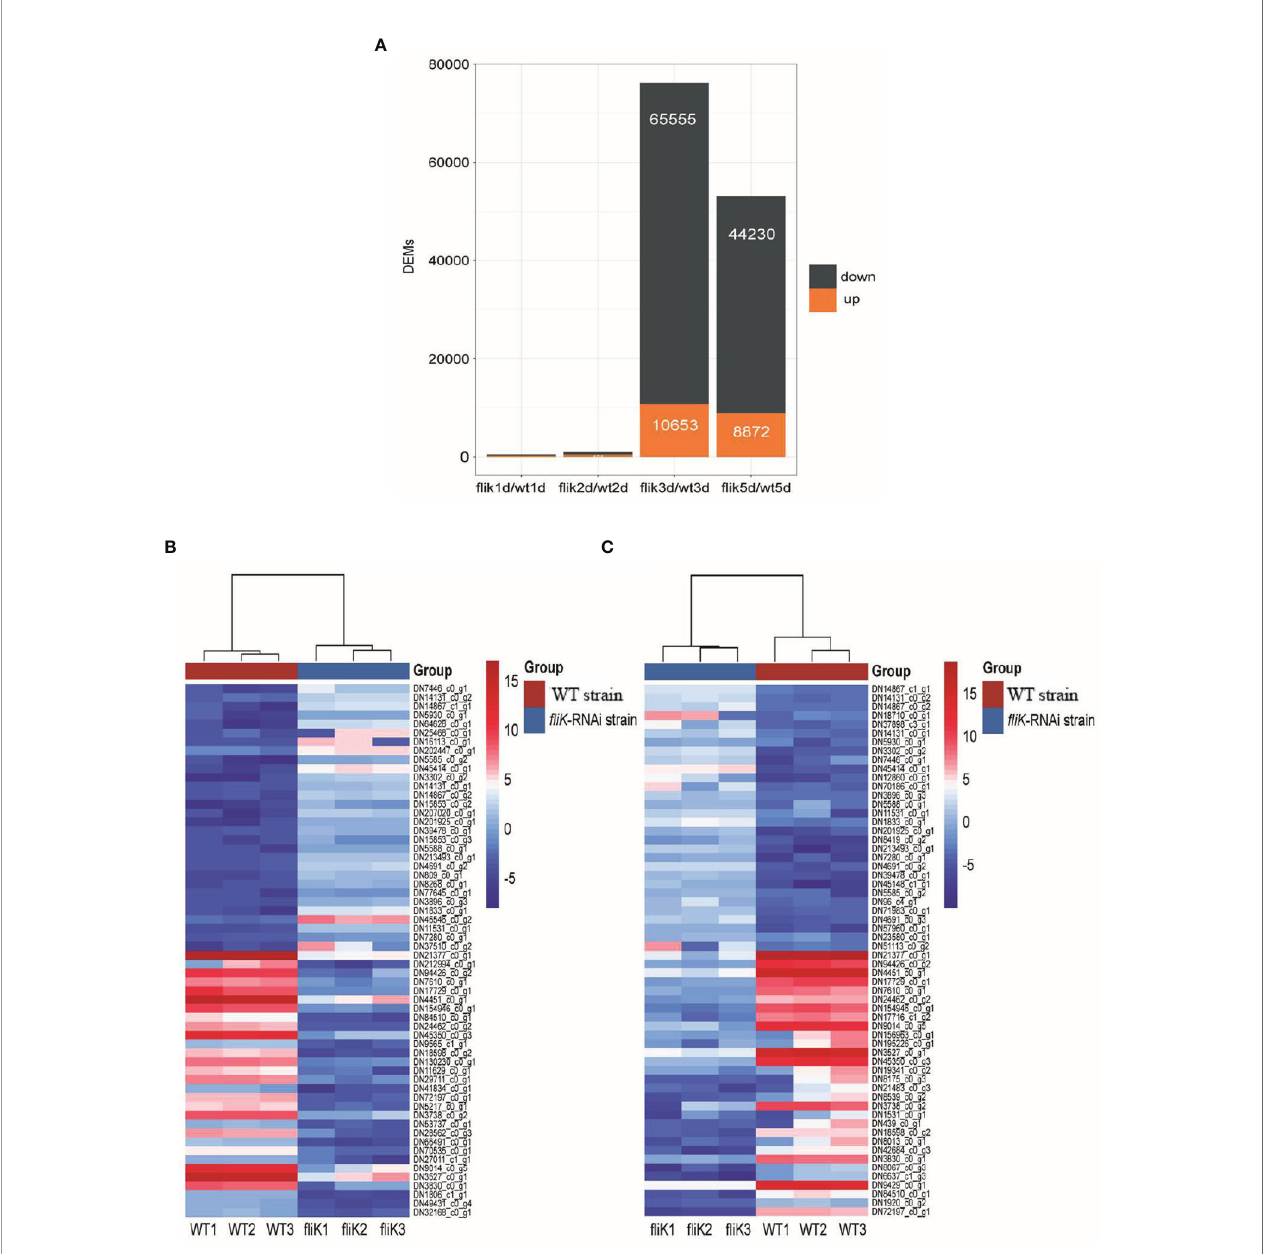
FIGURE 4 | Comparative transcriptome analysis of E. coioides spleens. (A) Statistics of comparative transcriptome DEGs ( fl iK -RNAi and WT strain infection groups). (B) Heat map of top 30 up-regulated and 30 down-regulated mRNAs from transcriptome of fl iK -RNAi and WT strain infection groups (3d). (C) Heat map of top 30 up-regulated and 30 down-regulated mRNAs from transcriptome of fl iK -RNAi and WT strain infection groups (5